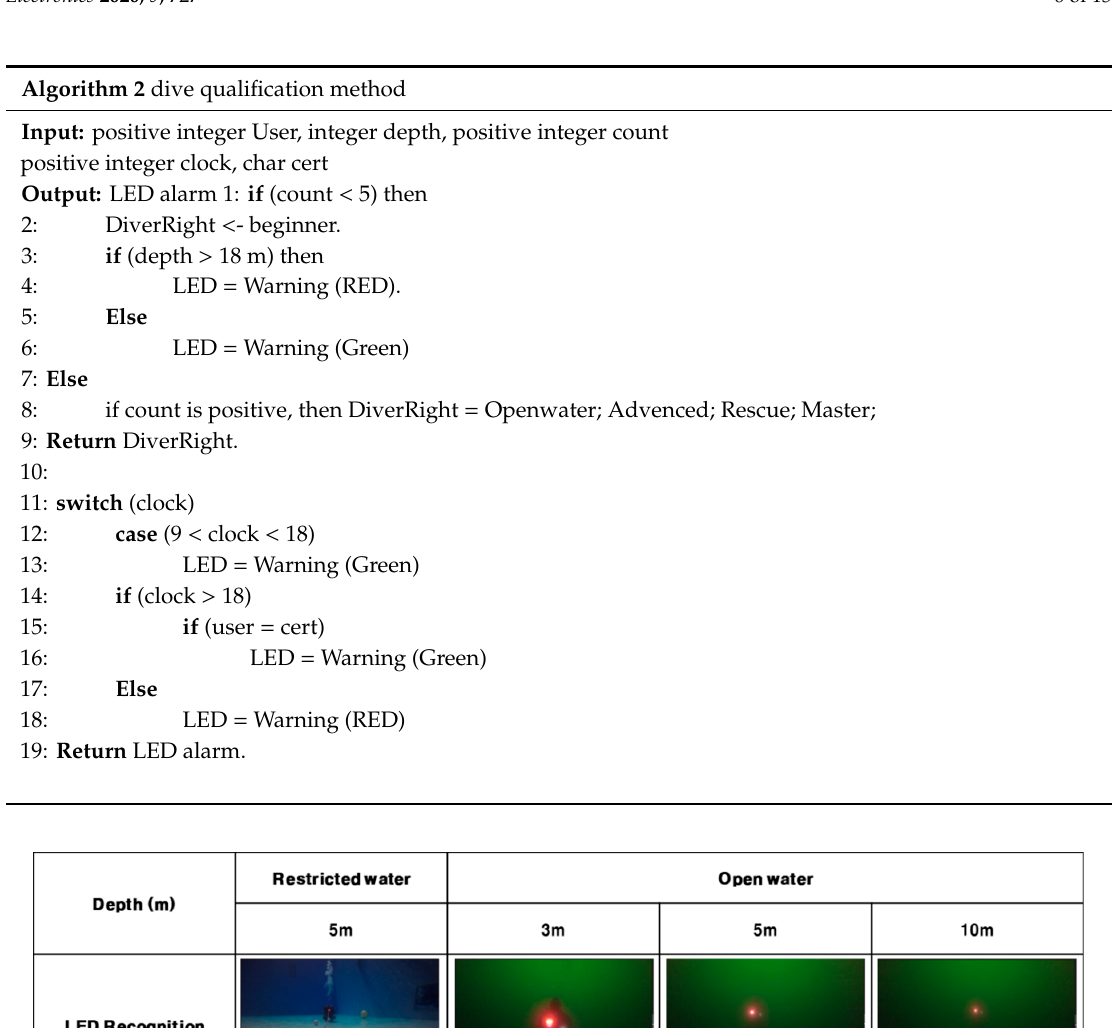
Table 2. Structure of DiverPAD data packet.